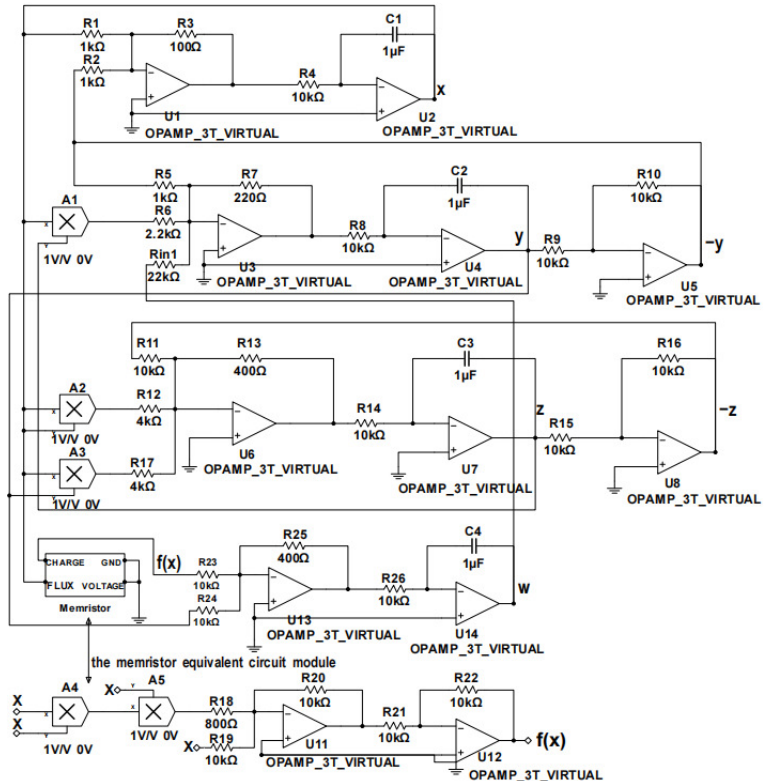
Figure 4. Circuit implementation diagram of the memristor-based hyper-chaotic Bao-like system.